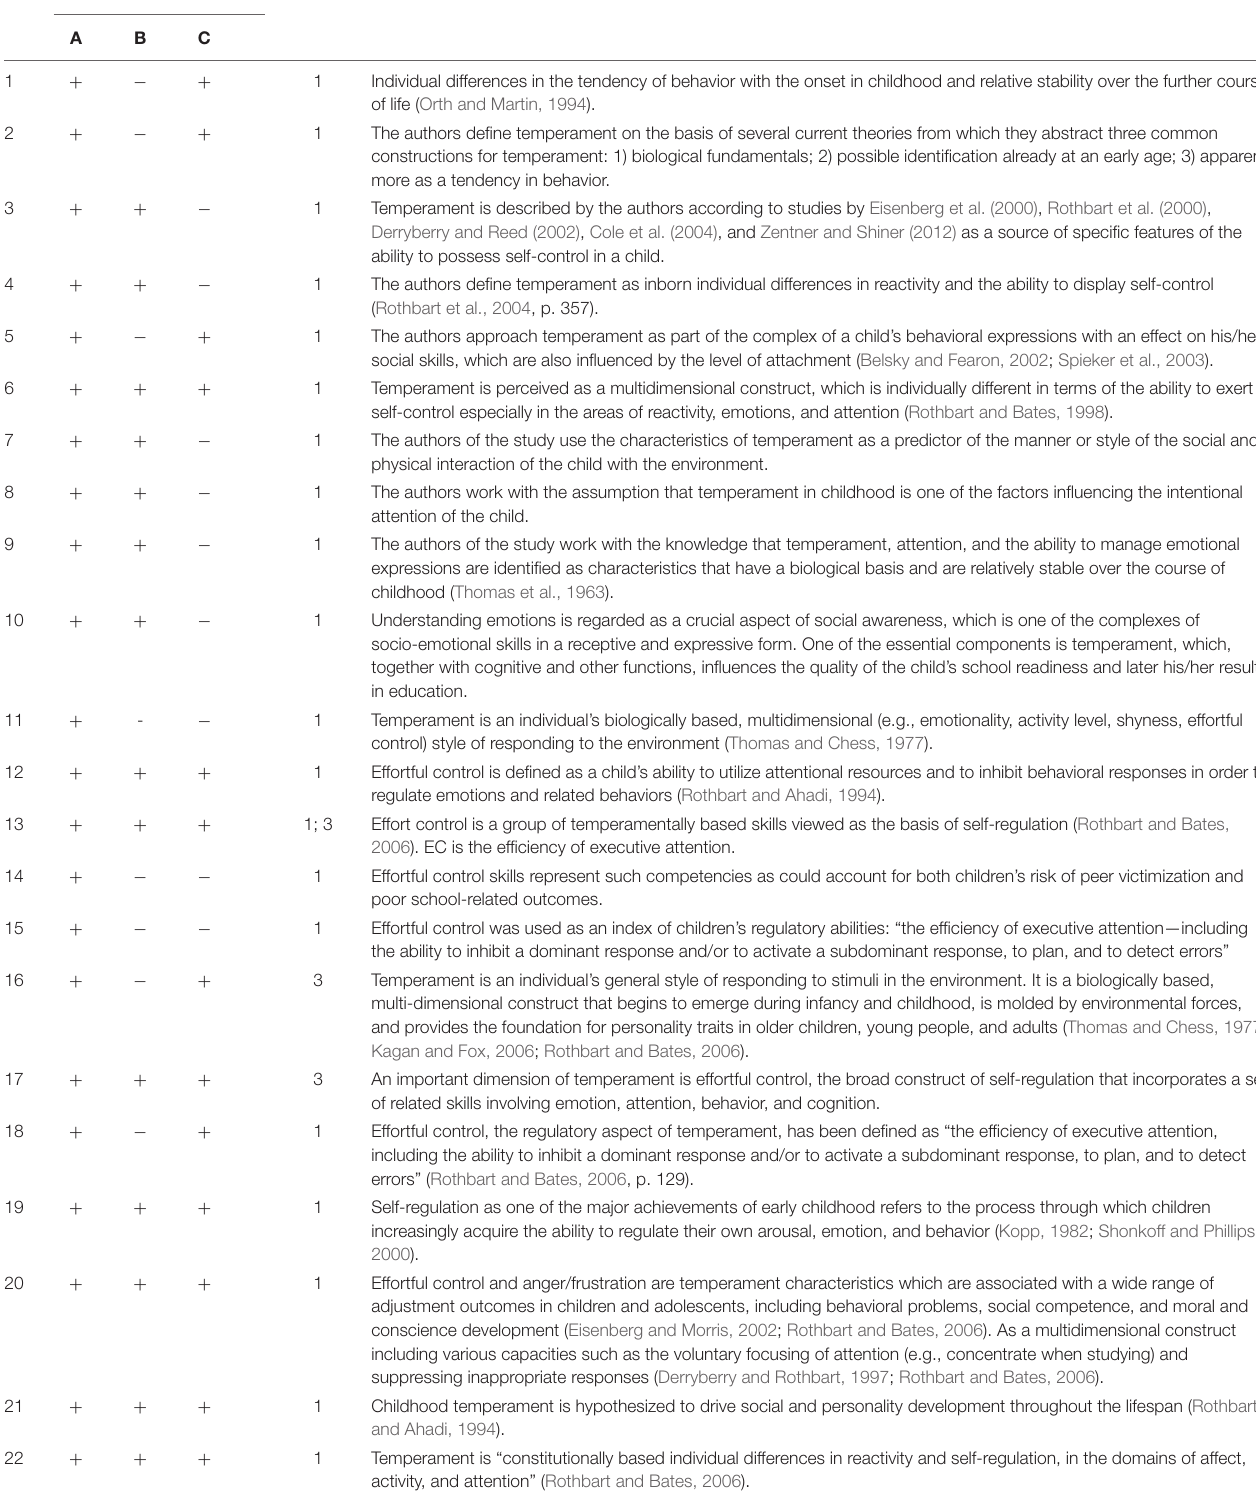
TABLE 3 | Qualitative indicator –